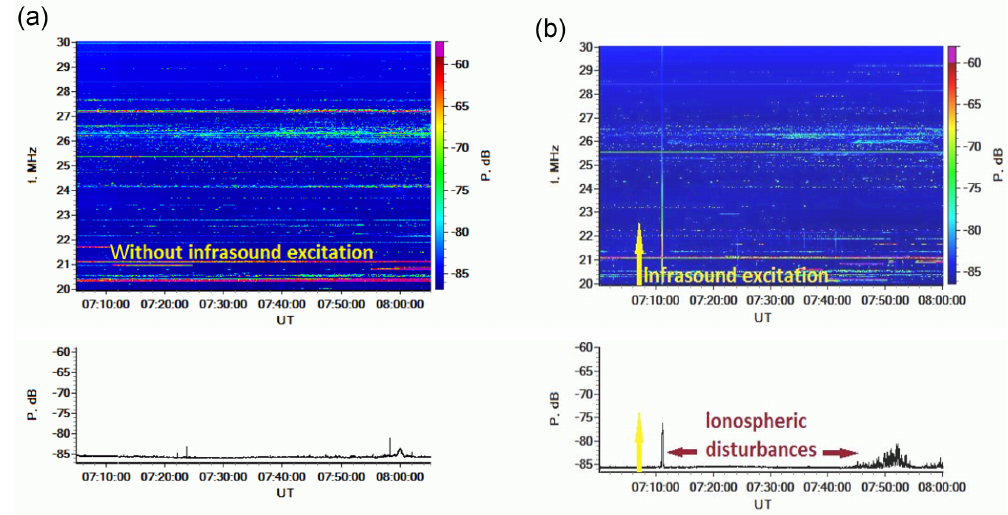
Figure 5. (a) The galactic background radio emission without infrasound excitation has been observed with the radio spectrograph of the HF radio telescope URAN-3: dynamic spectrum (upper panel) and time profile at a frequency of 24MHz (lower panel). The galactic background radio emission in the absence of infrasound excitation was characterized by a fairly uniform level of background radio emission across the band of 20–30MHz. (b) The galactic background radio emission with the infrasound excitation has been observed with the radio spectrograph of the HF radio telescope URAN-3: dynamic spectrum (upper panel) and time profile at a frequency of 24MHz (lower panel). After ∼ 4.5min from the start of the infrasound excitation (yellow arrows) an increase in intensity of the galactic radio background has been